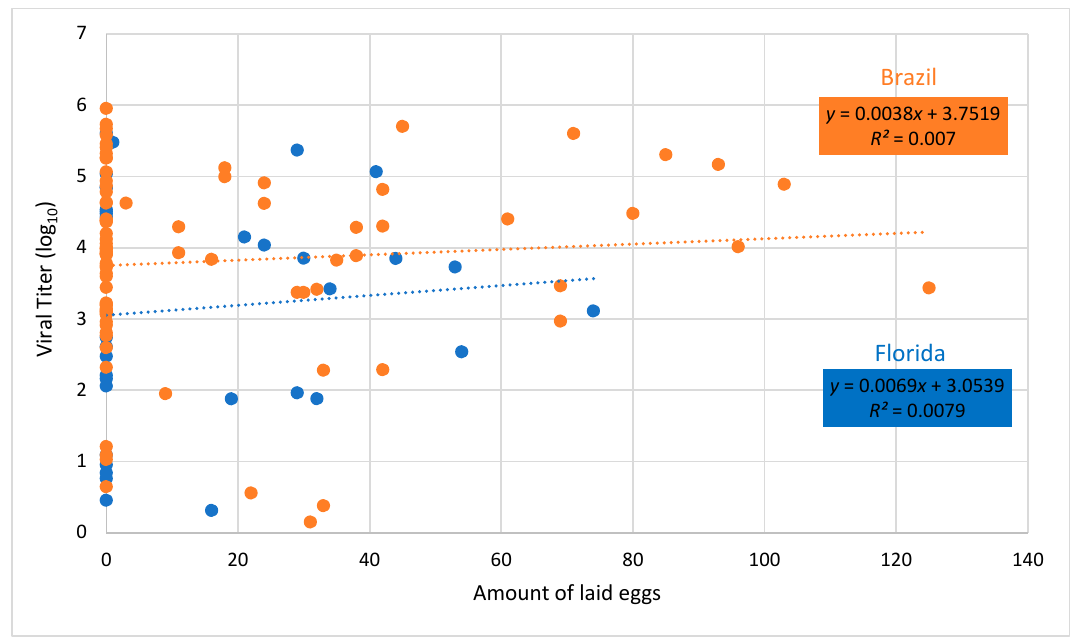
Figure 4. Body viral titer and number of eggs laid of female Aedes aegypti from Brazil and Florida infected with Mayaro virus. Dashed lines drawn through viral titer values show the best fit for Brazil and Florida. Viruses 2020 , 12 , x